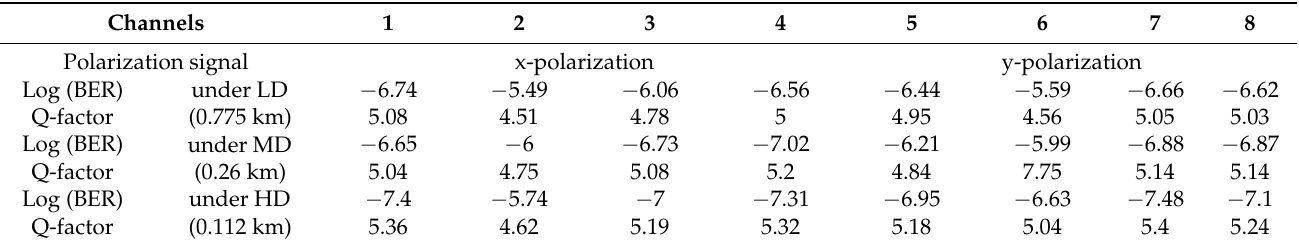
Table 5. log (BER) values and Q-factors of eight channels of FSO-PDM/PV-OCDMA system under dust storm conditions and propagation ranges.